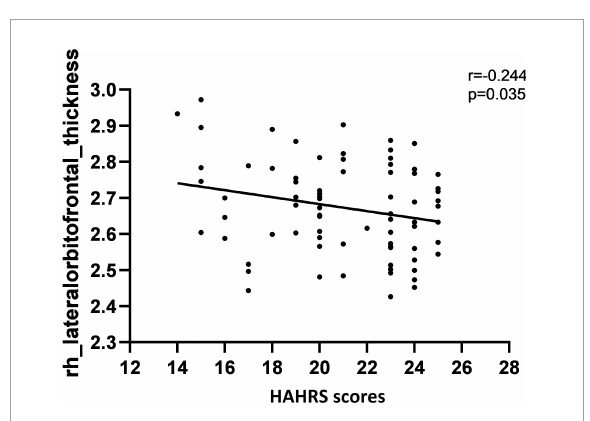
FIGURE4 The cortical thickness of rh-lateral OFC was negatively correlated with the severity of auditory verbal hallucination, as assessed by HAHRS scores.